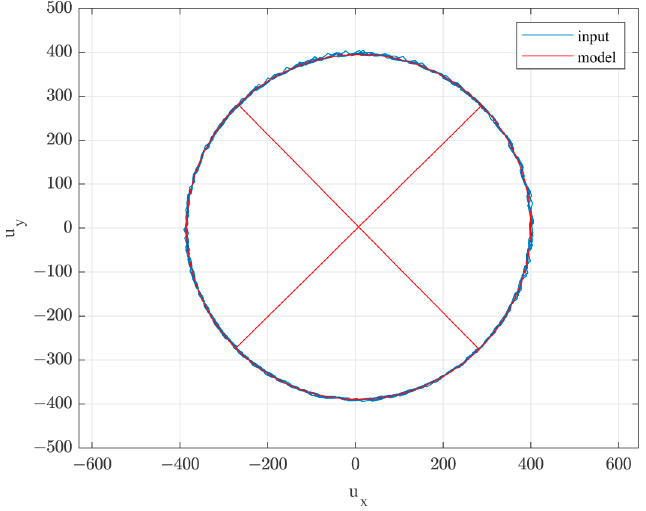
Figure 8. The input signal trace and the identified MR sensor model.